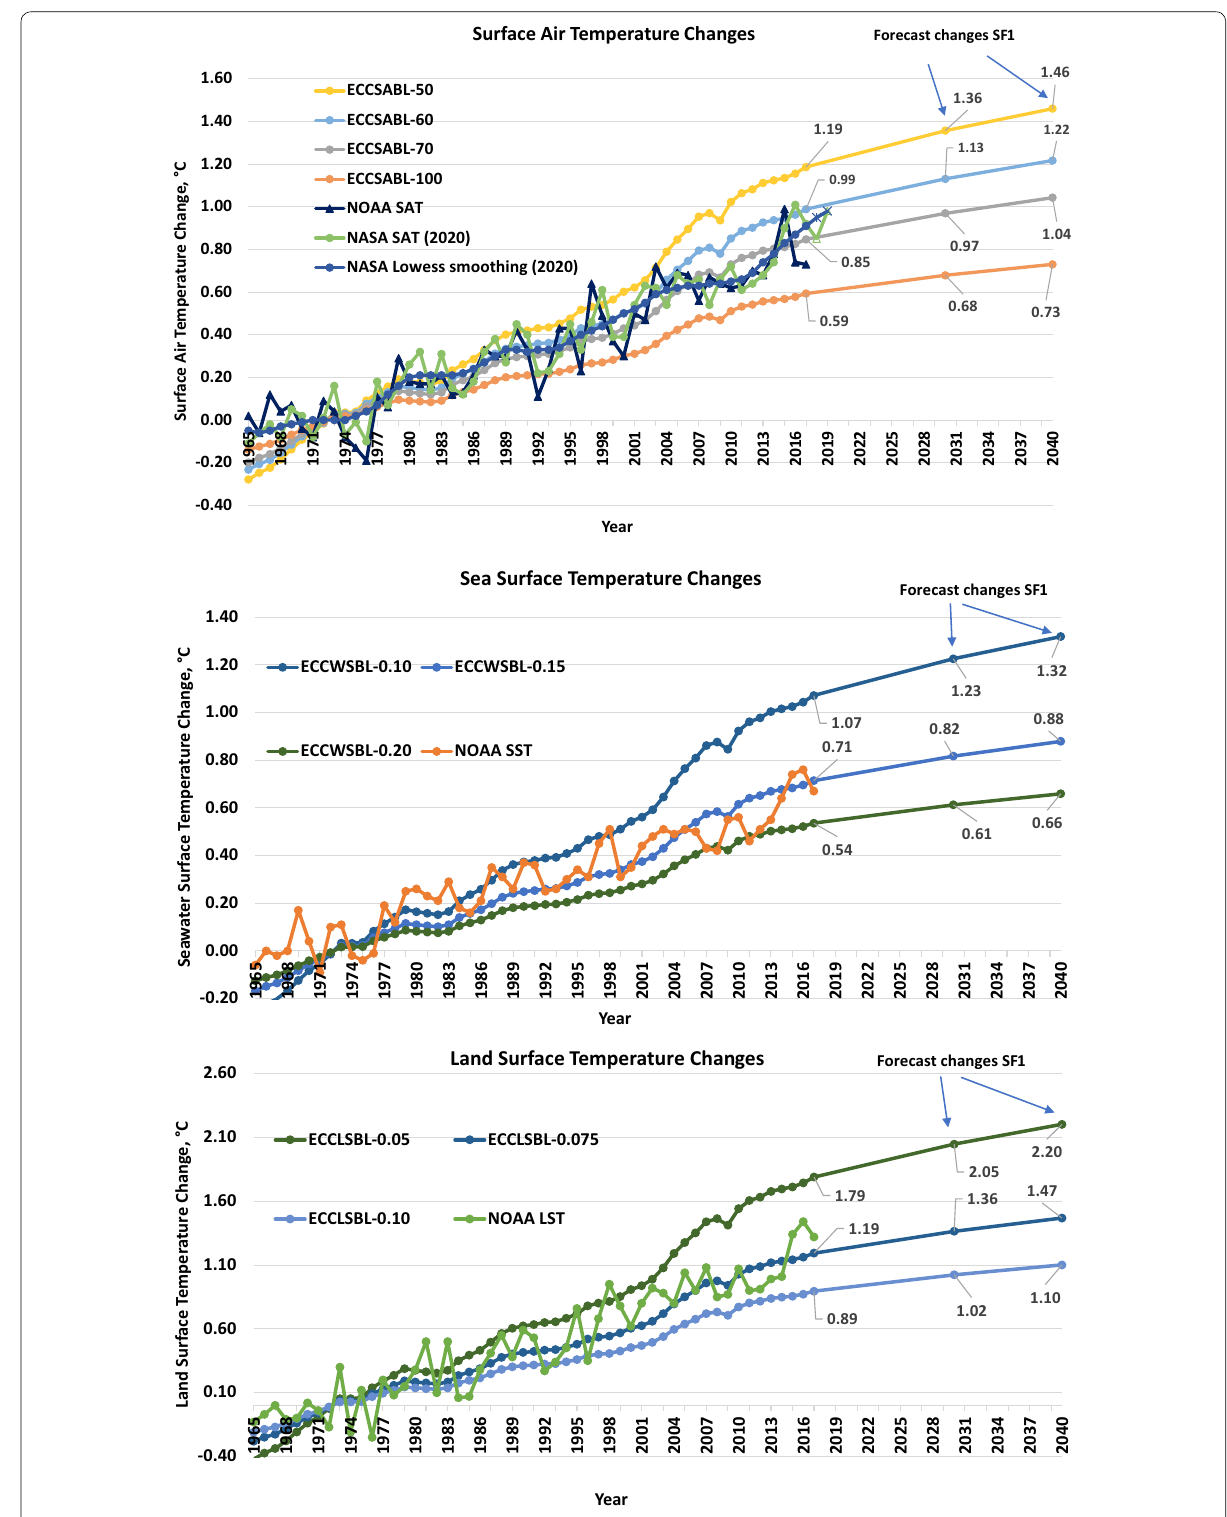
Fig. 3 Calculated past temperature changes at the lower and upper depth limits of equivalent climate change surface air boundary layer (top), equivalent climate change waters surface boundary layer (middle), and equivalent climate change land surface boundary layer (bottom), and the temperature change forecast as well as their observed temperature anomalies under scenario